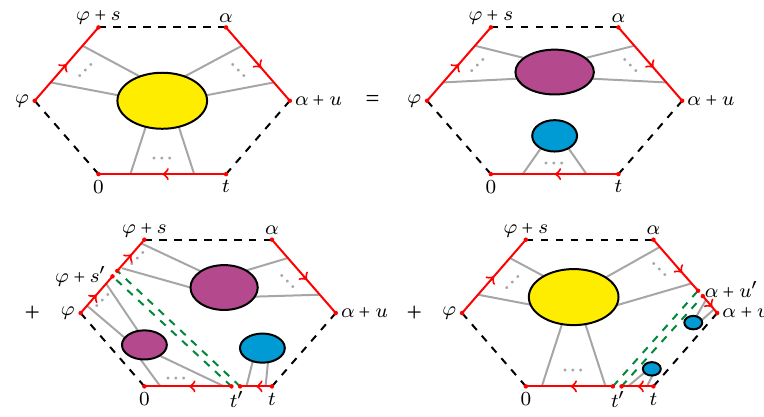
Figure 10 . Diagrammatic interpretation of the integral equation